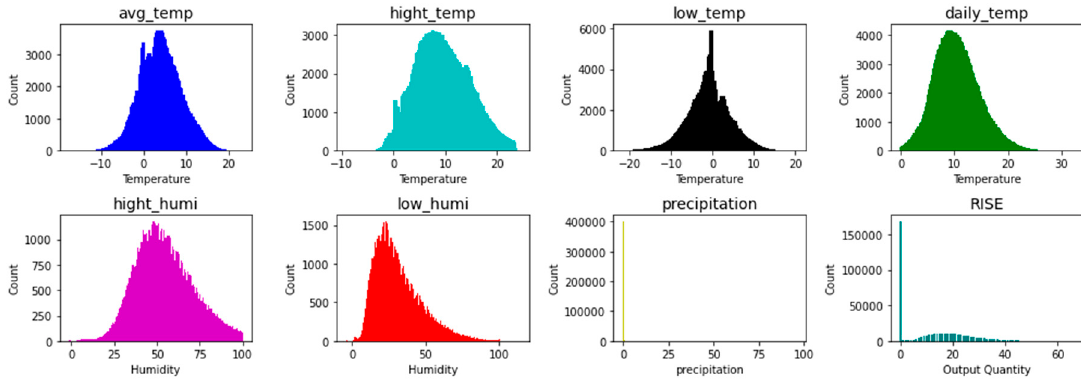
Figure 8. The statistical information of the used data set.